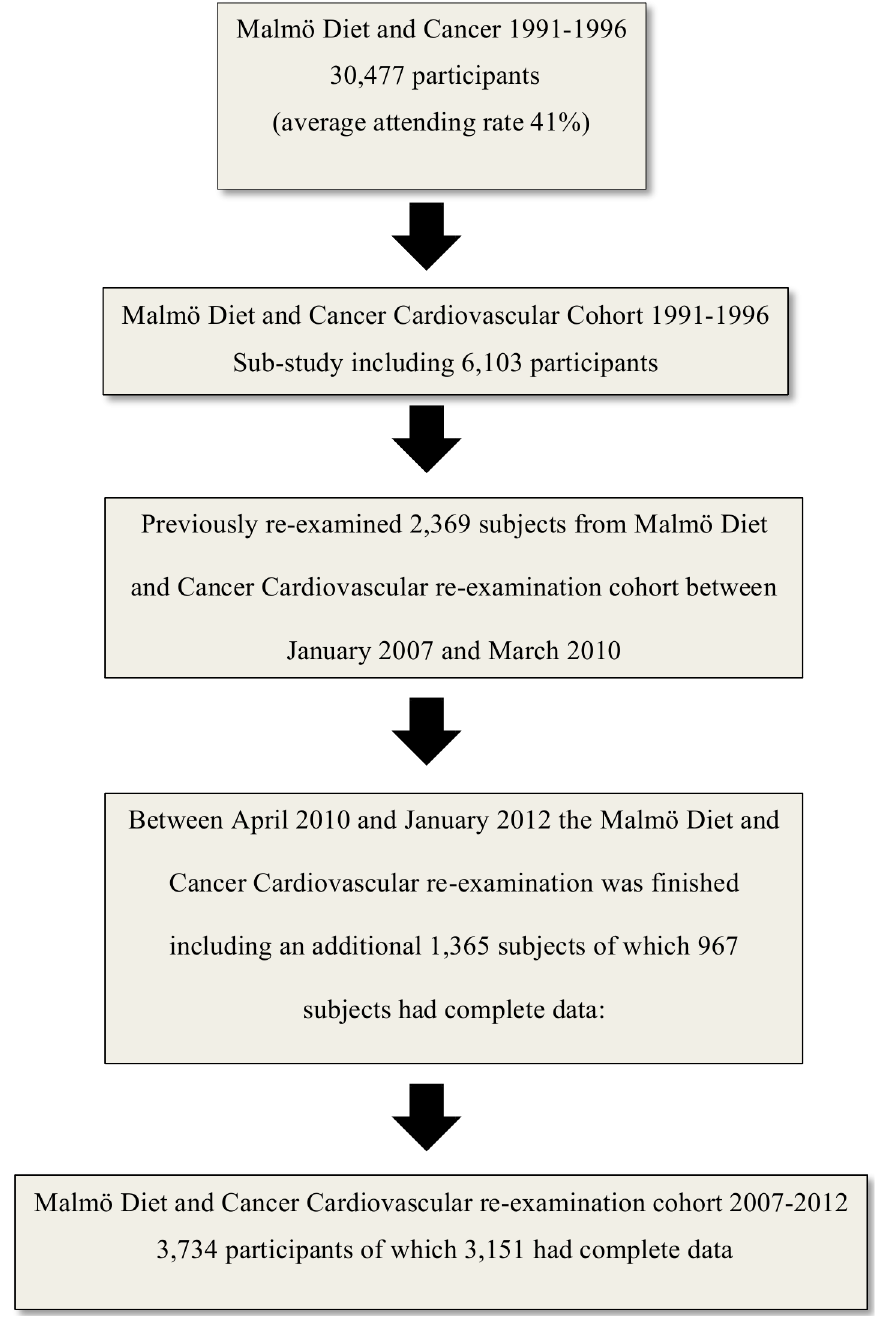
Fig 1. Flow chart describing the